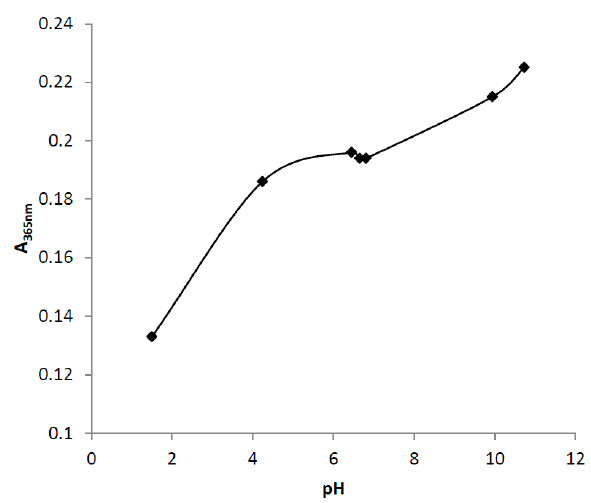
Figure 6 . Changes in the absorption at 365 nm of enriched fractions of the major chromophore arising from glucose degradation (1.3 mg/mL) with pH.